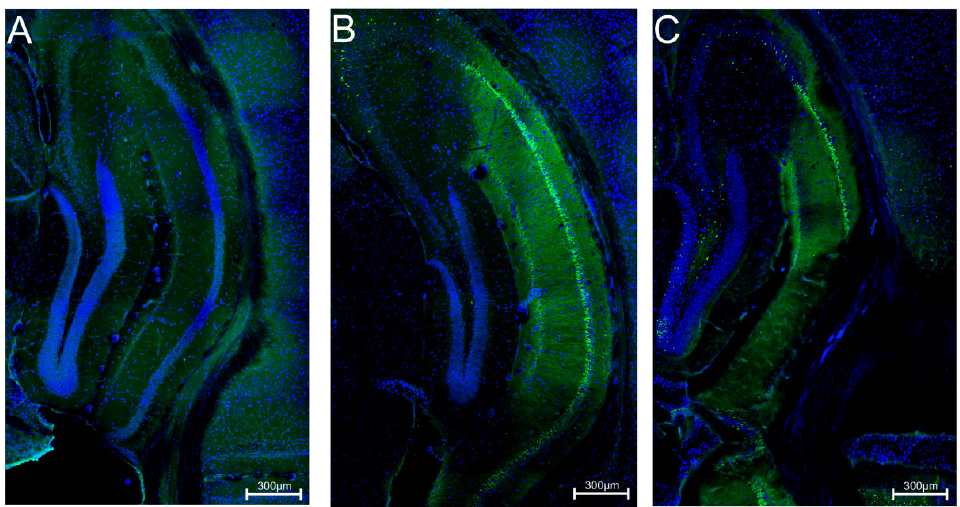
Figure 4. Qualitative assessment of neuroprotective properties of C-11. Results are presented in the form of pictures of hippocampal areas of selected hemisphere of one mouse from each test group. ( A )—Control; ( B )—PILO, 300 mg/kg; ( C )—C-11, 100 mg/kg. The degenerate neurons are stained green; blue—cell nuclei.